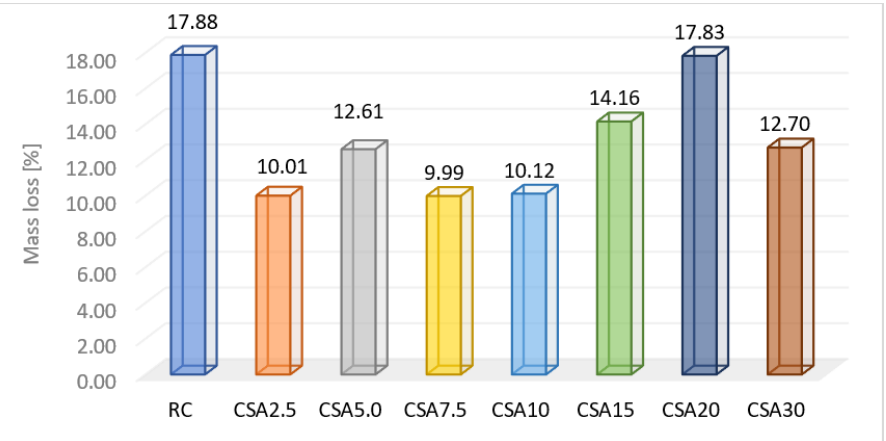
Figure 14. Mass loss due to the action of the 18% HCl solution action